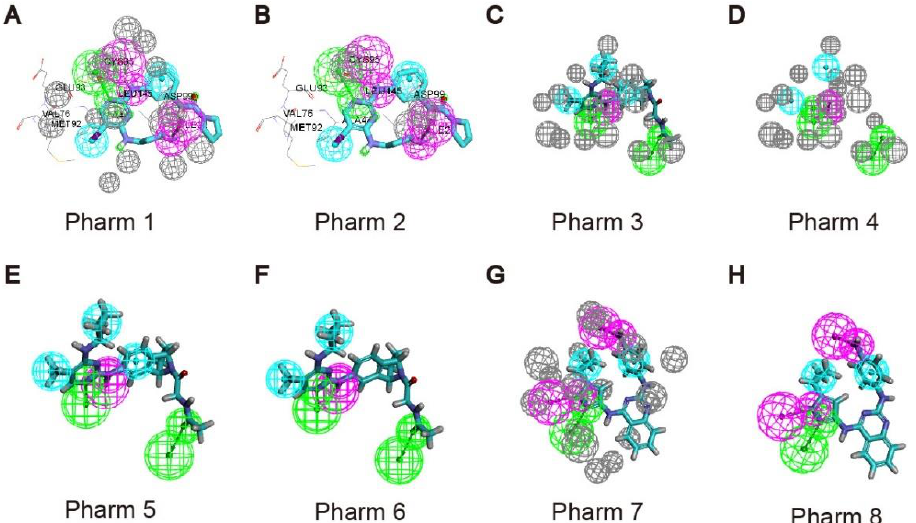
Figure 1. Generate pharmacophore models of UKL1 in complex with ligands. ( A , B ) Generate pharmacophore models of 5CI7; ( C – F ) Generate pharmacophore models of 6QAS; ( G , H ) Generate pharmacophore models of 4WNO.